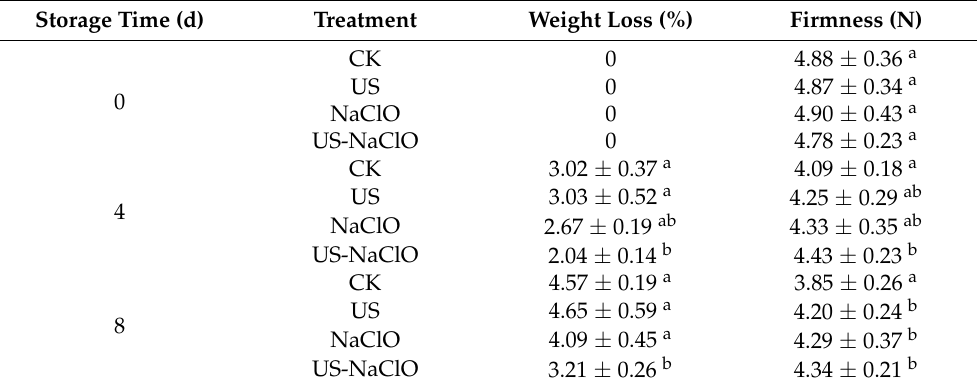
Different superscripts in the same column indicate significant